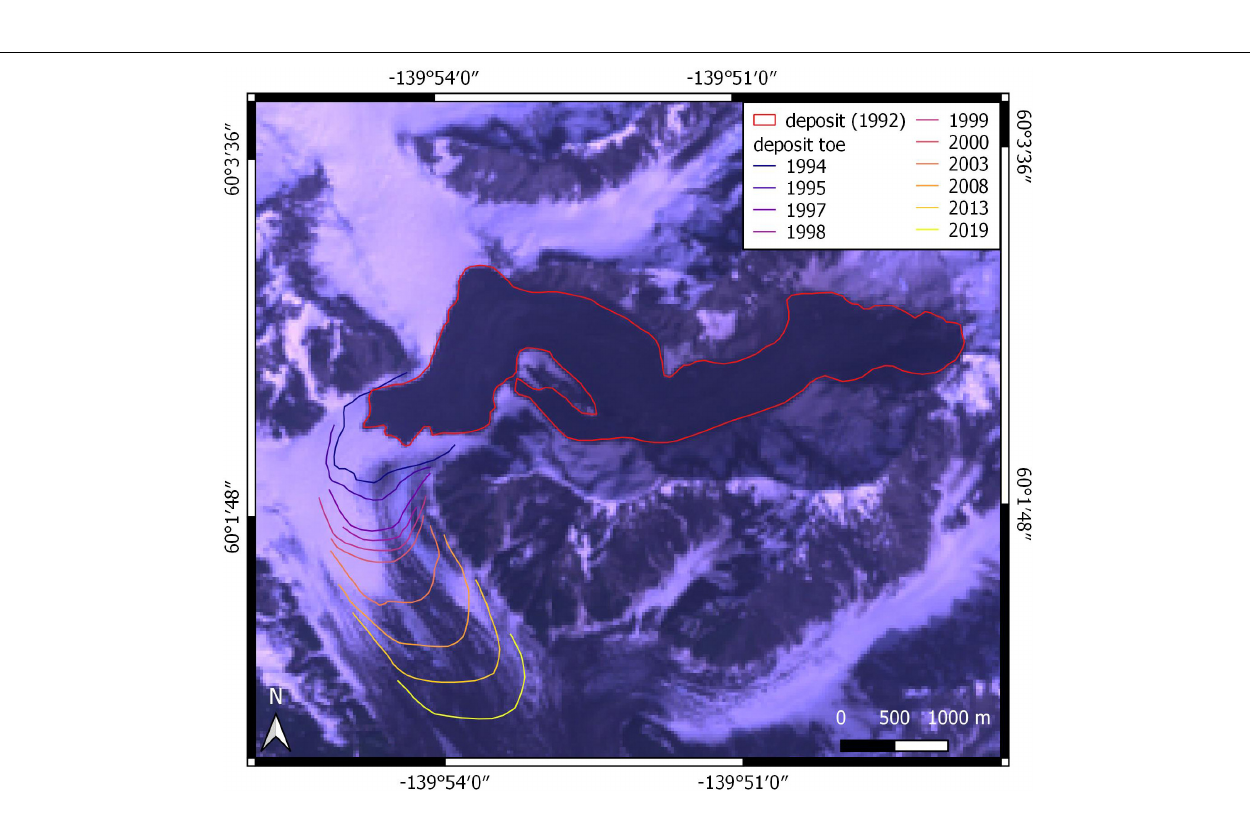
Frontiers in Earth Science |